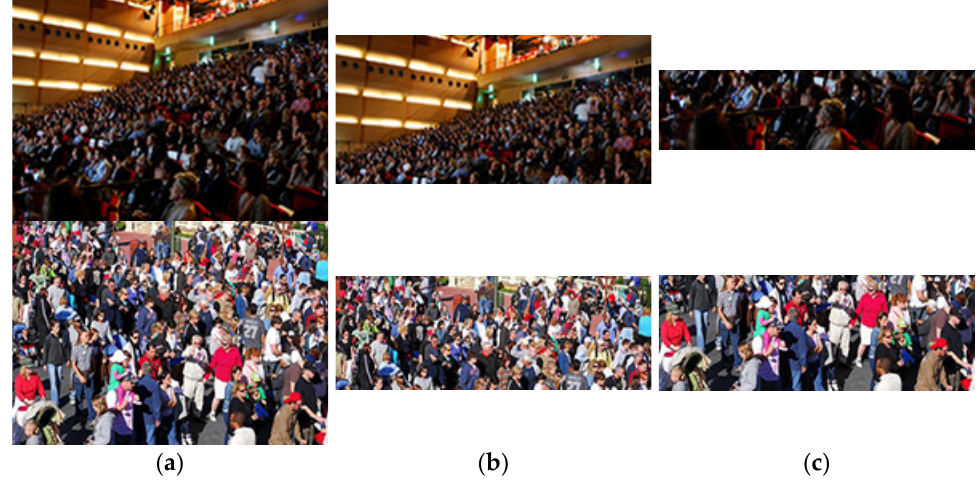
Figure 2. Segmentation Based on Scene Adaption. ( a ): input image samples; ( b ): distant view image; ( c ): close-up view image. Two dense scene images are divided adaptively with the division ratio of 0.34 and 0.52, respectively.